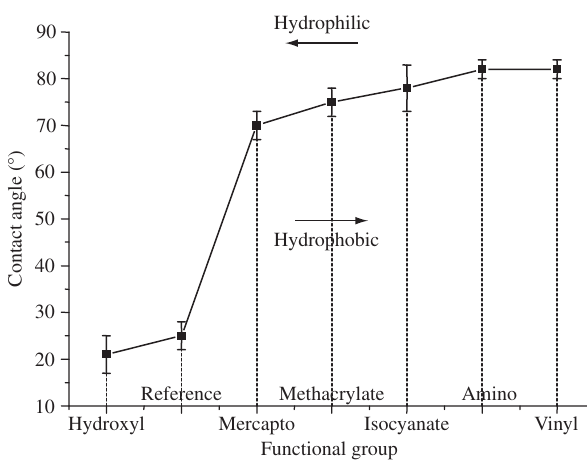
Figure 3. Contact angle measurements for control, hydrophilic and silane modified glass tiles.